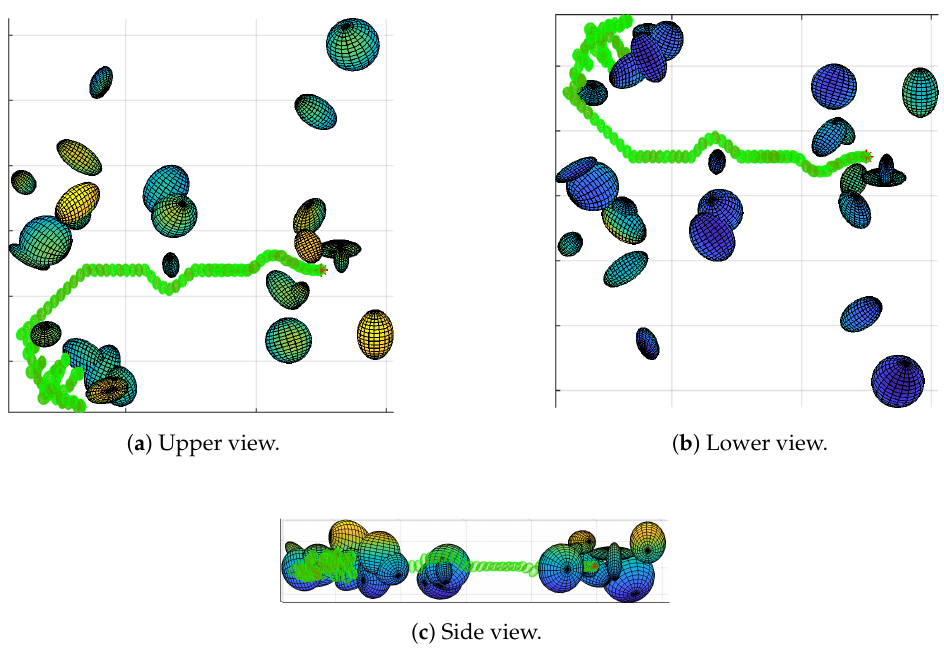
( a ) Upper view. ( b ) Lower view.